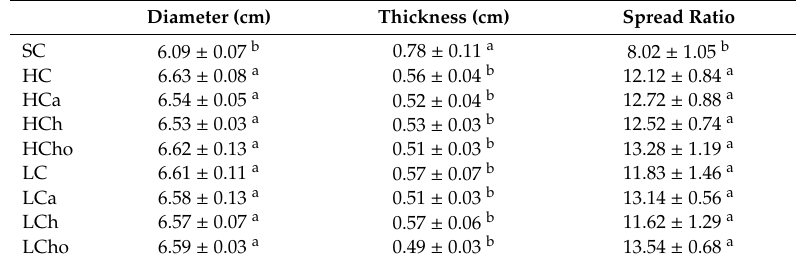
Table 1. Effect of calcium carbonate, chitosan, and chitooligosaccharide on spread factor in brown sugar cookies.